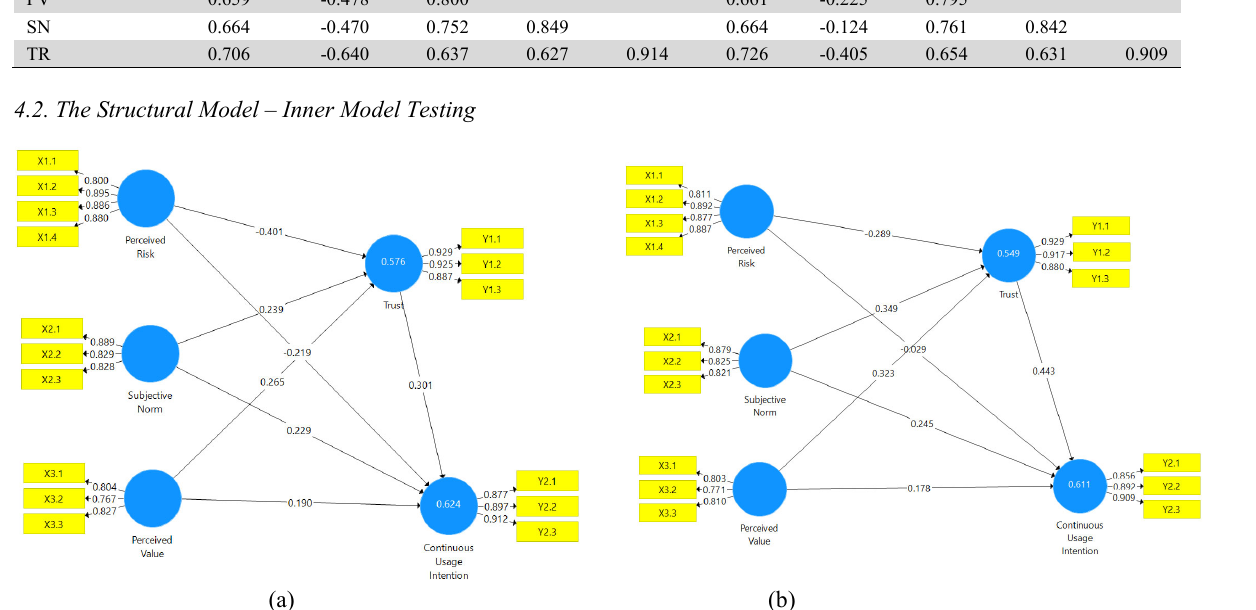
Fig. 2. The Structural Model (a) on Millennial and (b) on